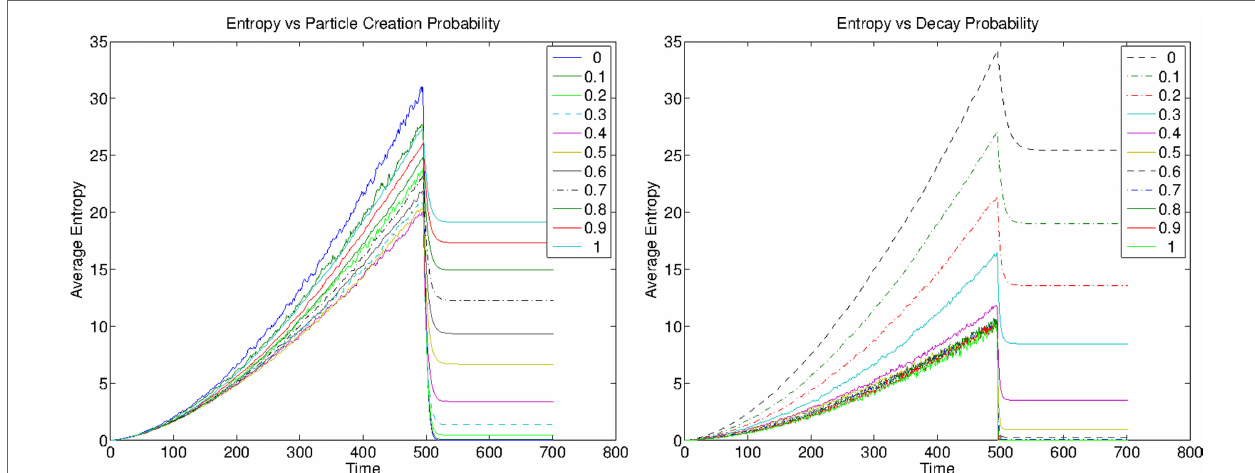
FIGURE 1 | Evaluation of the mean entropy as a function of time in the reinforcement–decay model . The growth of the graph stops at T = 500, and afterward, the network converges to a stable graph. Left: dynamical entropy for varying particle creation probability. Right: dynamical entropy for varying Decay